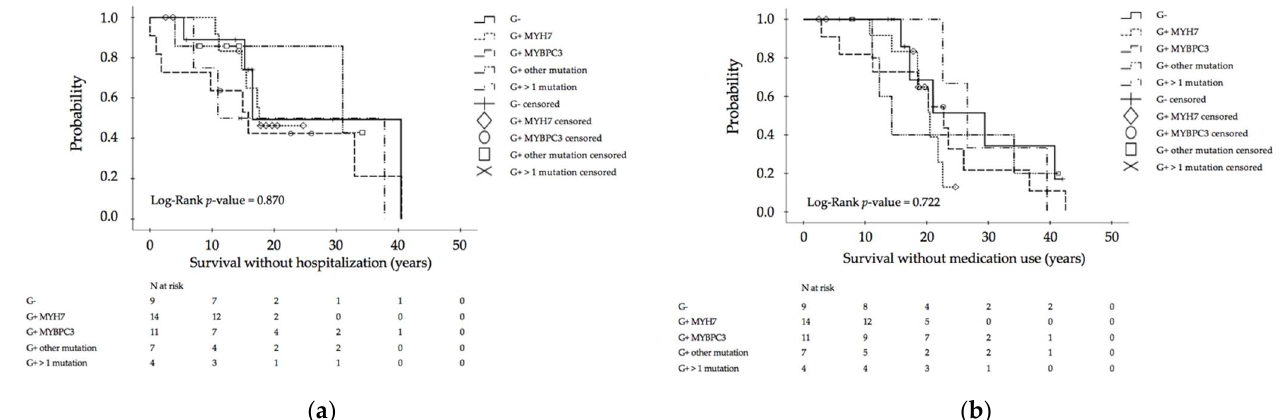
Figure 4. Morbidity and clinical outcome Part II: ( a ) Kaplan–Meier calculation of survival without hospitalization in hypertrophic cardiomyopathy (HCM) patients, depending on different mutations; ( b ) Kaplan–Meier calculation of survival without medication use. SCD: sudden cardiac death, G−: genotype-negative patients, G+ MYH7: genotype-positive patients with β-myosin heavy chain single-mutation, G+ MYBPC3: genotype-positive patients with myosin binding protein C single-mutation, G+ others: genotype-positive patients with cardiac troponin T2, cardiac troponin I3, α tropomyosin and myosin light chain 2 single-mutations, G+ multiple mutation: genotype-positive patients with compound mutations.